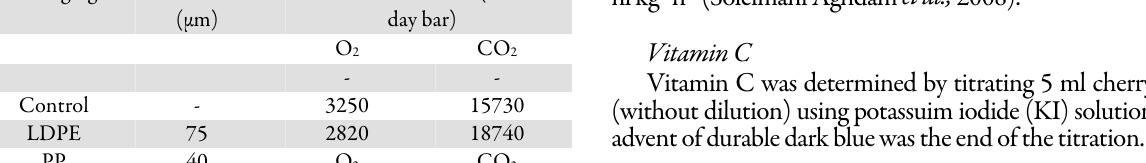
Table 1. Permeability of used packages, as related to modified atmosphere Packaging